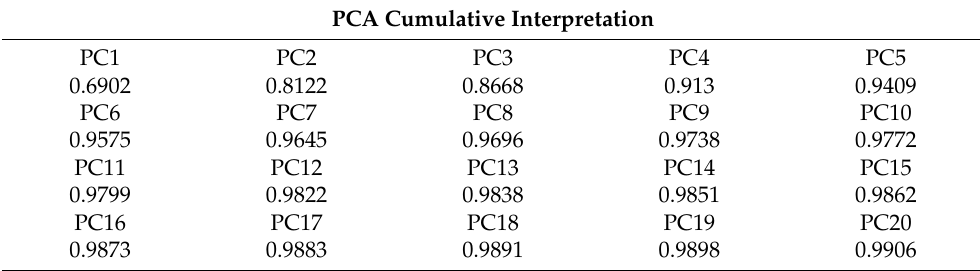
Table 2. PCA cumulative interpretation